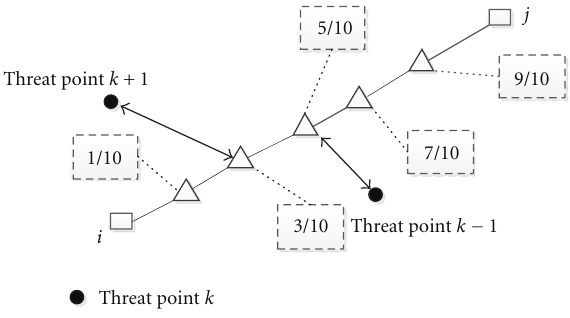
Figure 2: Modeling of the UCAV threat cost